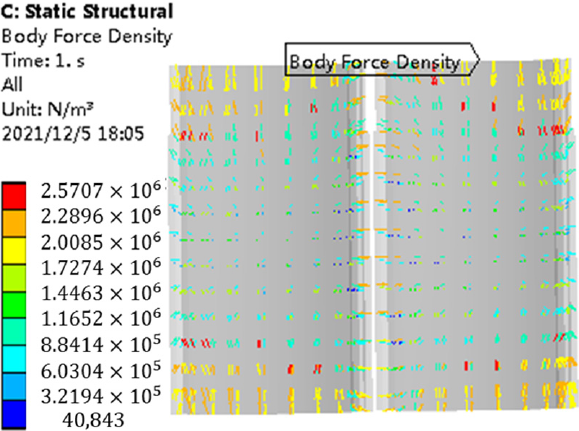
Figure 15. Volumetric force density vector map.